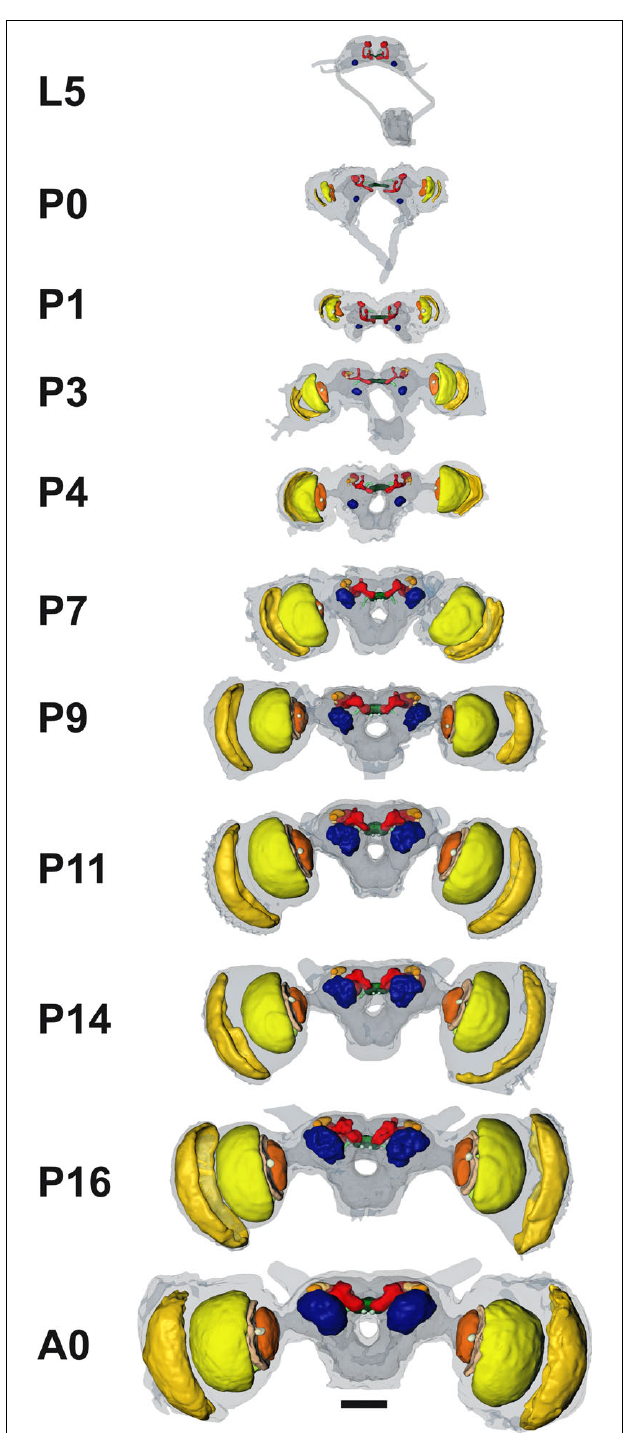
FIGURE 6 | 3D brain reconstructions of representative developmental stages. Most conspicuous are the prominent overall size increases (especially in the optic lobes) and the fusion of the subesophageal and supraesophageal ganglion. Note the outward tilting movement of the mushroom bodies, together with a backward rotation. These brains represent the reference points for the 4D visualization ( Movie S1 in Supplementary Material). Anterior view; scale bar: 500